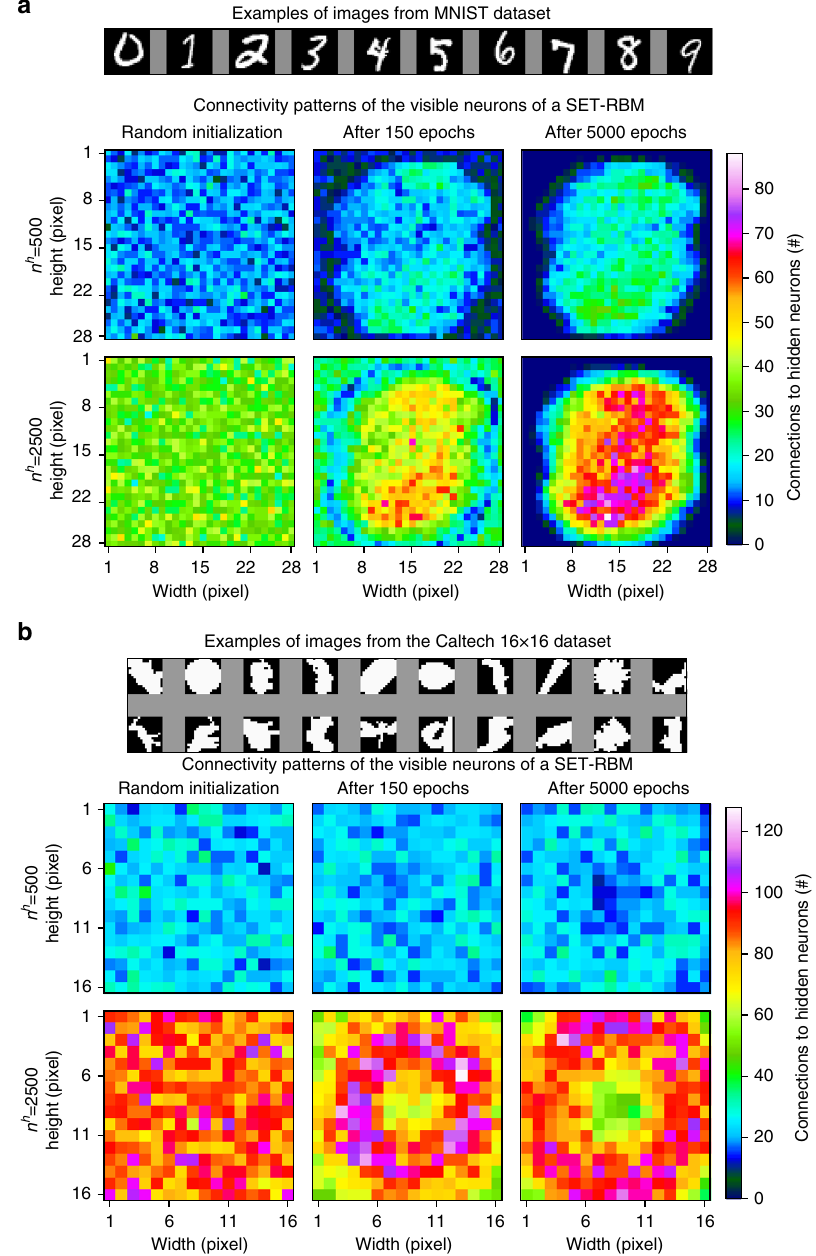
Fig. 4 SET-RBMs connectivity patterns for the visible neurons. a On the MNIST dataset. b On the Caltech 101 16 × 16 dataset. For each dataset, we have analyzed two SET-RBM architectures, i.e. 500 and 2500 hidden neurons. The heat-map matrices are obtained by reshaping the visible neurons vector to match the size of the original input images. In all cases, it can be observed that the connectivity starts from an initial Erdös – Rényi distribution. Then, during the training process, it evolves towards organized patterns which depend on the input